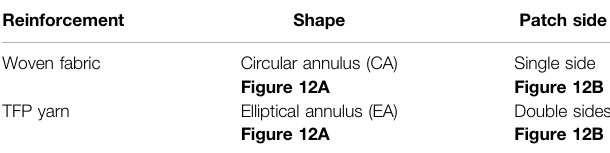
TABLE 7 | Patching parameters to be studied in virtual test